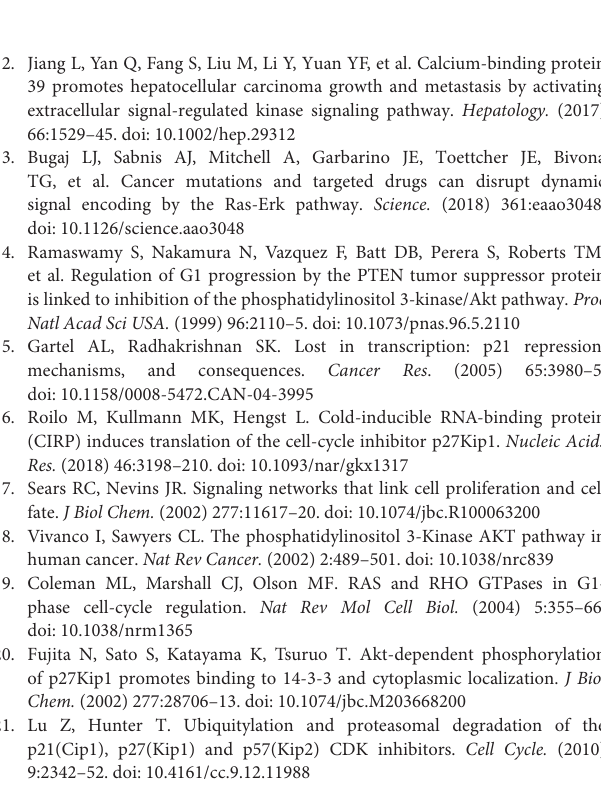
Table S1 | IHC score of CRC and normal tissues of 53 patients. Table S2 | Cox multivariate analysis of independent risk factors for overall survival. Table S3 | The correlation between EXOSC5 expression and molecular